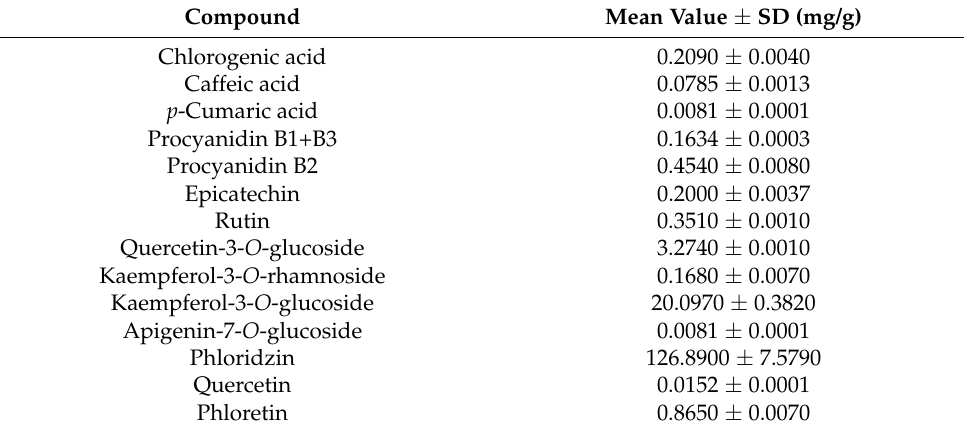
Table 2. Quantitative analysis of OAALE determined by HPLC-DAD-FLD